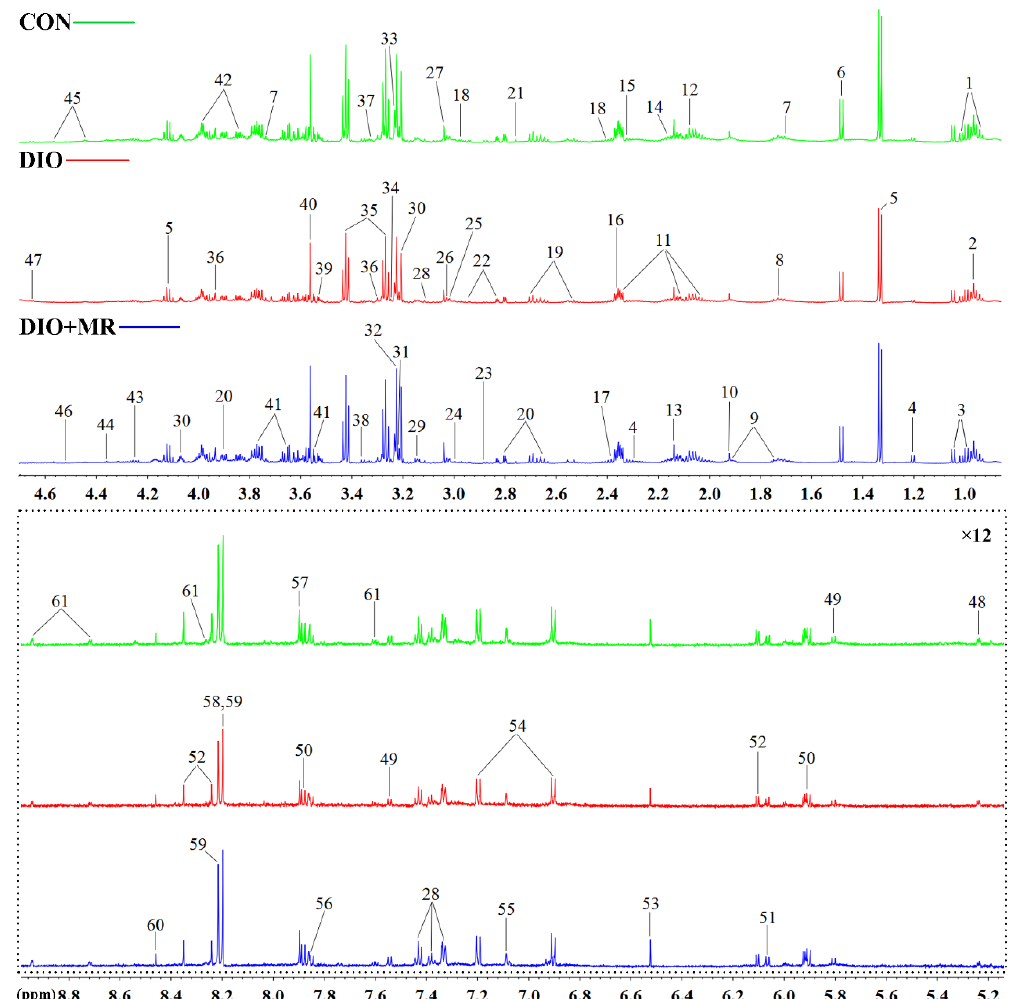
Figure 4. The randomly selected 1 H-NMR spectra of spleen tissue samples. 1, Isoleucine; 2, 2-Aminobutyrate; 3, Valine; 4,